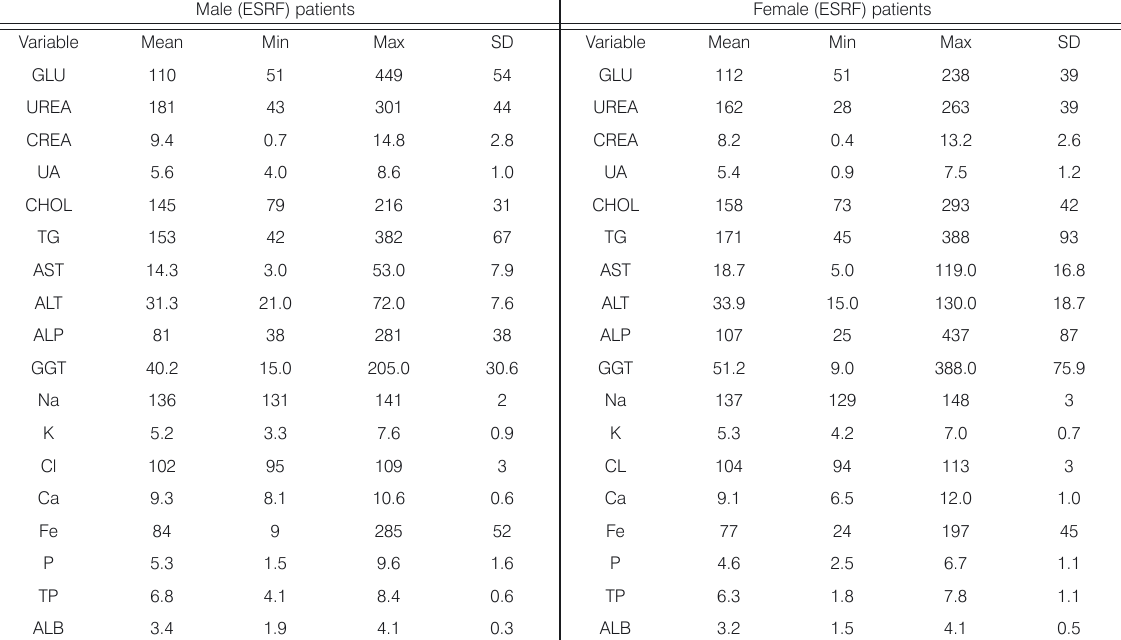
Figure 1. Hierarchical dendrogram of biochemical variables for all healthy